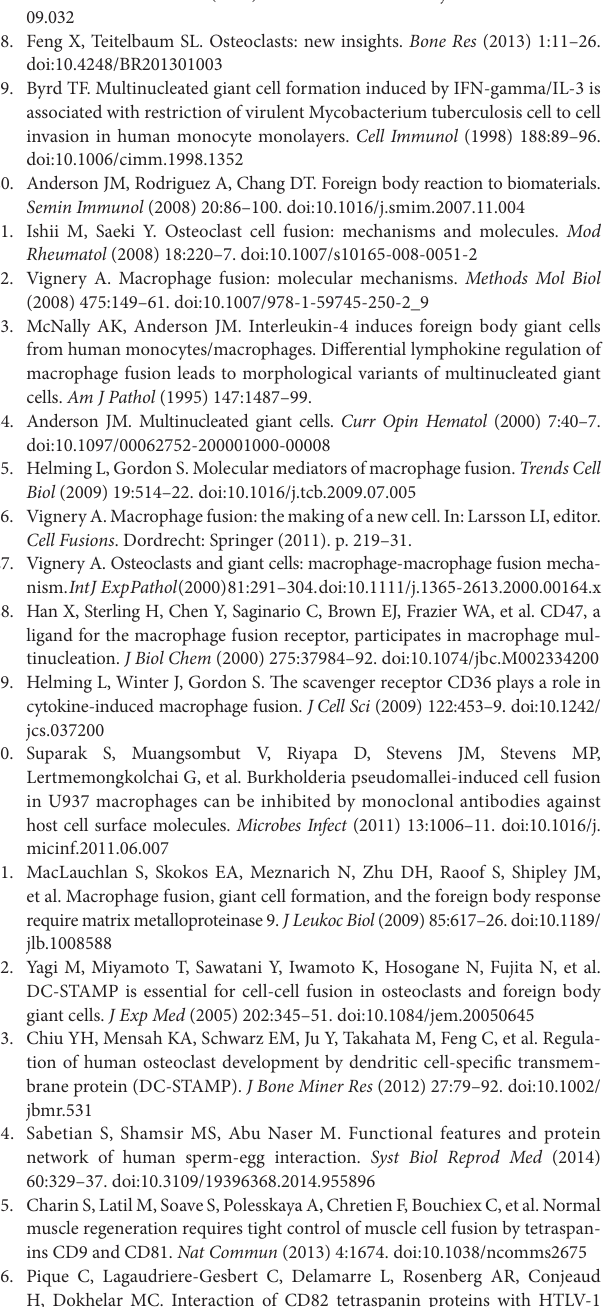
(Classical), CD14 ++ CD16 + (Intermediate), and CD14 + CD16 + (non­classical) monocytes were gated as shown and sorted. The purity of the sorted populations was always > 90%. FigUre s2 | Morphologies of the three monocyte­derived giant cell (MGC) types observed during fusion assays. A representative low magnification image with nuclei in red and F­actin in blue. Langhans giant cells can be identified by their horseshoe or ring­shaped nuclear arrangement and are typically the smallest. Foreign body giant cells (FBGC) are larger and contain more nuclei in a stacked central cluster. Syncytial giant cells (SGC) are the largest, have